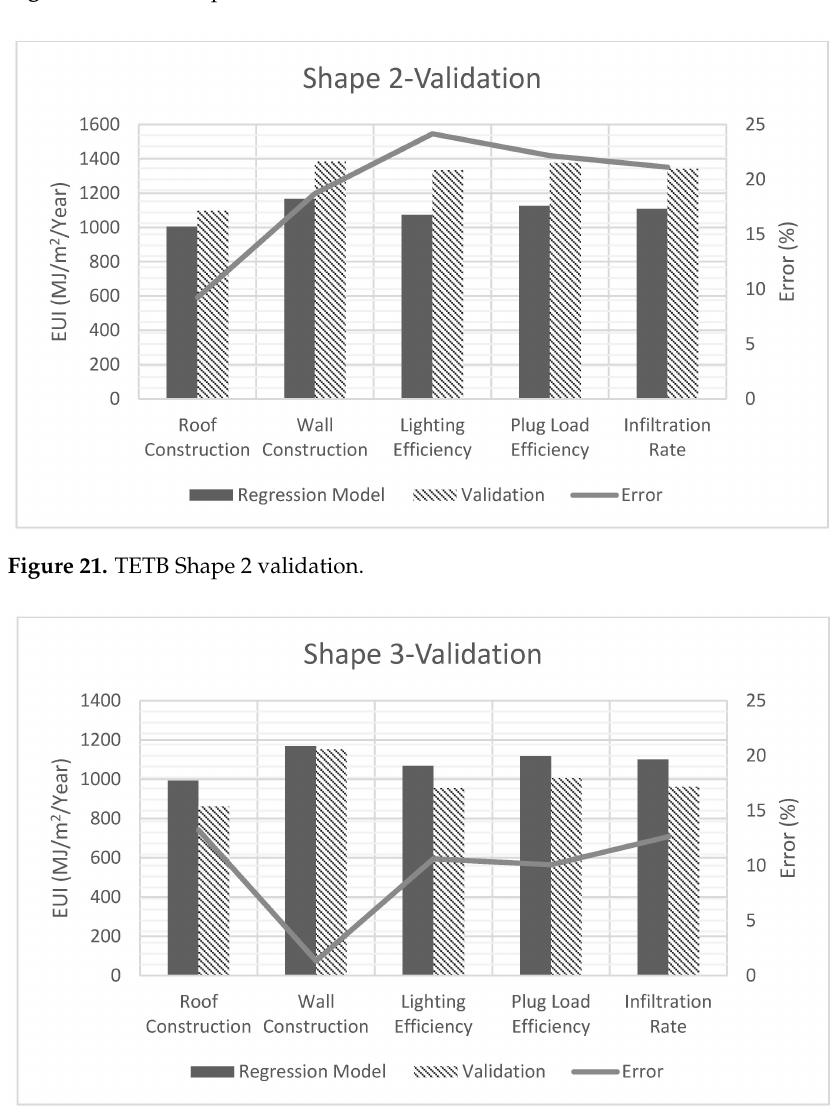
Figure 20. TETB Shape 1 validation.